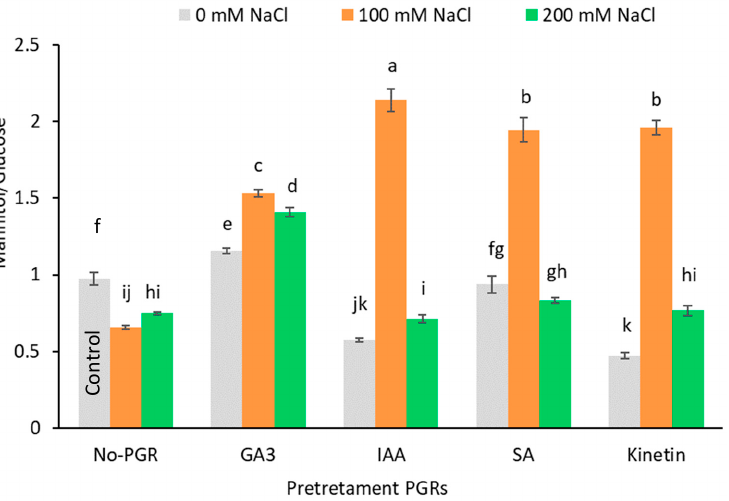
Figure 5. Effect of salt stress on ratio Manitol/Glucose in leaf of Olea europaea plants pretreated with plant growth regulators (PGRs). Data are expressed as mean ± SE (n = 4). Means followed by the same letter are not significantly different according to the LSD test ( p < 0.05).